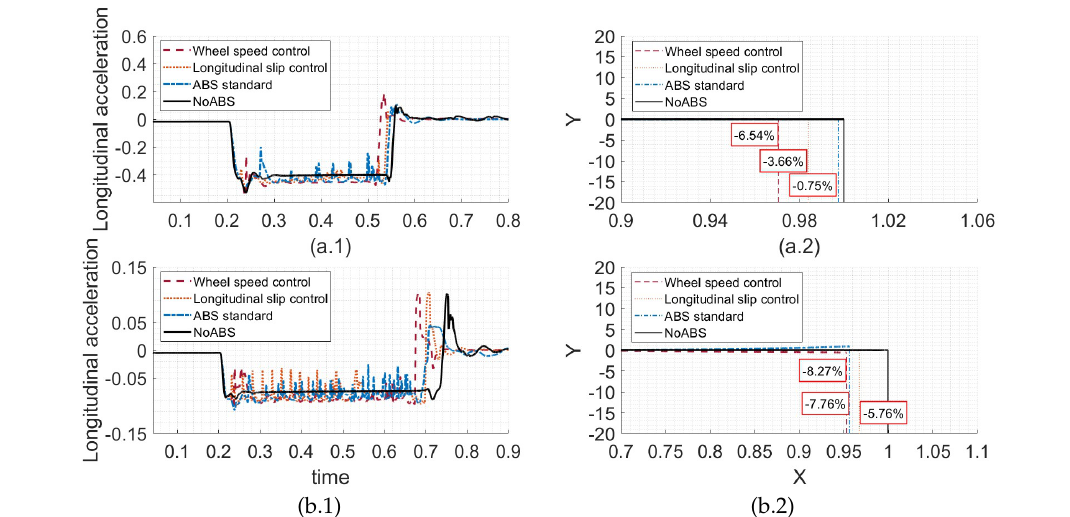
Figure 9. Figure ( a.1 , b.1 ) shows the longitudinal vehicle acceleration, and Figure ( a.2 , b.2 ) shows the car trajectory in a longitudinal braking from 130 to 0 km/h with and without ABS . ( a ) Dry surface of friction level equal to 1. ( b ) Wet surface of friction level equal to 0.7. X and Y stand for longitudinal and lateral vehicle displacement and figures ( a ) have the same horizontal axis, time, as well as figures ( b ), X.